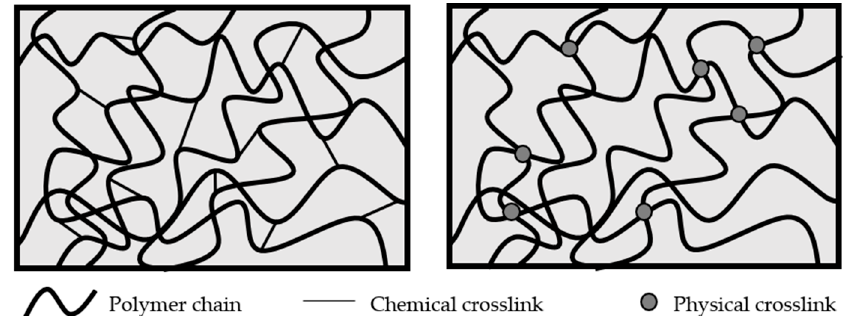
Figure 1. Schematic representation of polymer gels formed by chemical crosslinks ( left image) or physical crosslinks ( right image) [2].